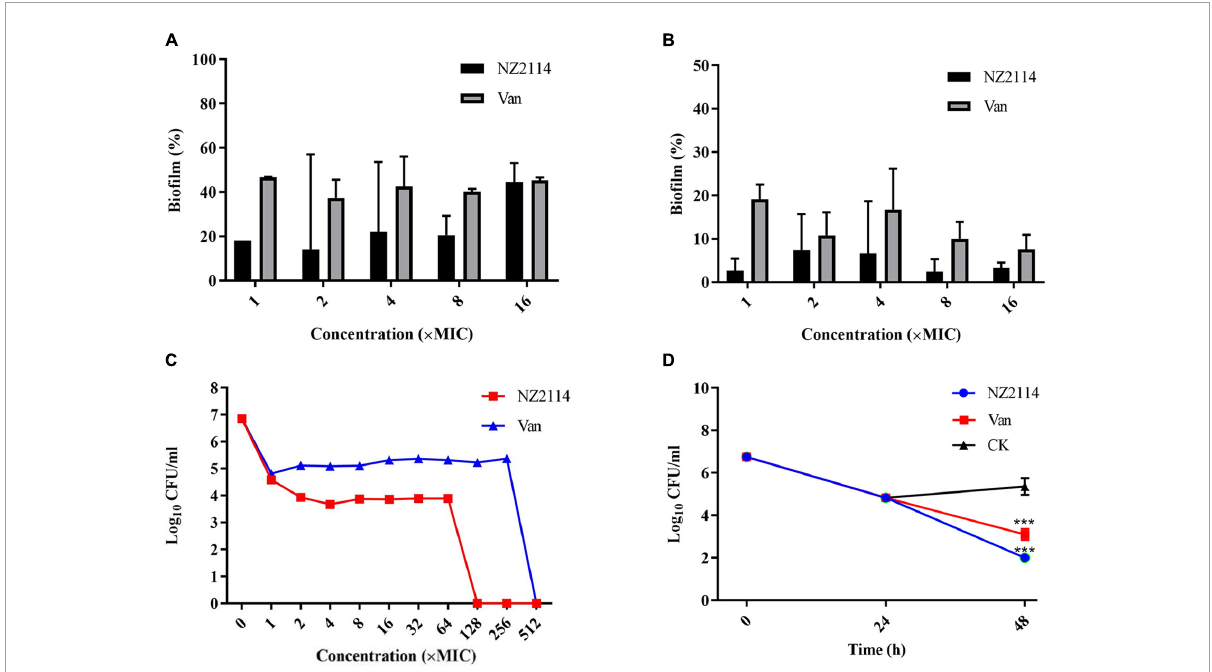
FIGURE2 Effects of NZ2114 on S. dysgalactiae biofilms and bacteria in biofilms. (A) Inhibition effect of NZ2114 on biofilms formation. (B) Eradication effect of NZ2114 on mature biofilms. (C) Bactericidal activity of NZ2114 against the established biofilms. (D) Bactericidal activity of NZ2114 against